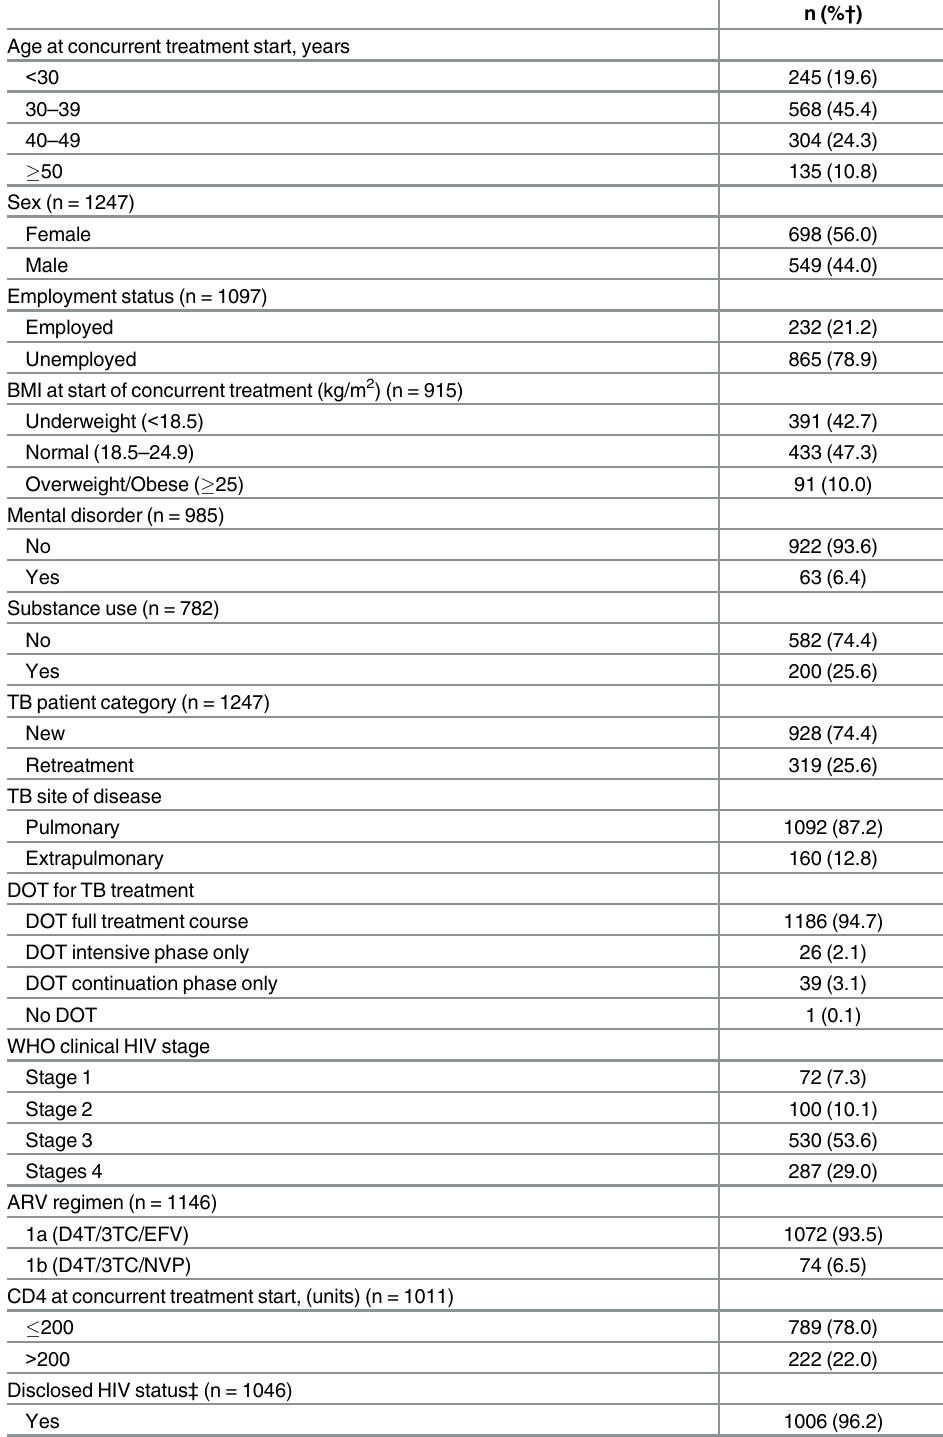
Table 1. Demographic, clinical, and social characteristics of patients receiving concurrent TB/HIV treatment in selected THAT ’ SIT clinics, South Africa, 2008 – 2010 (N = 1,252). BMI = body mass index; TB = tuberculosis; IRZE = isoniazid, rifampin, pyrazinamide, ethambutol; DOT = directly observed therapy; WHO = World Health Organization; HIV = human immunodeficiency virus; ARV = antiretroviral;